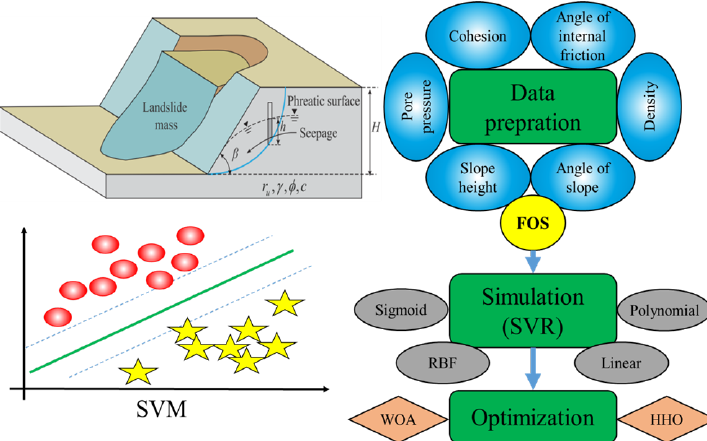
Figure 3. The main flowchart of the current